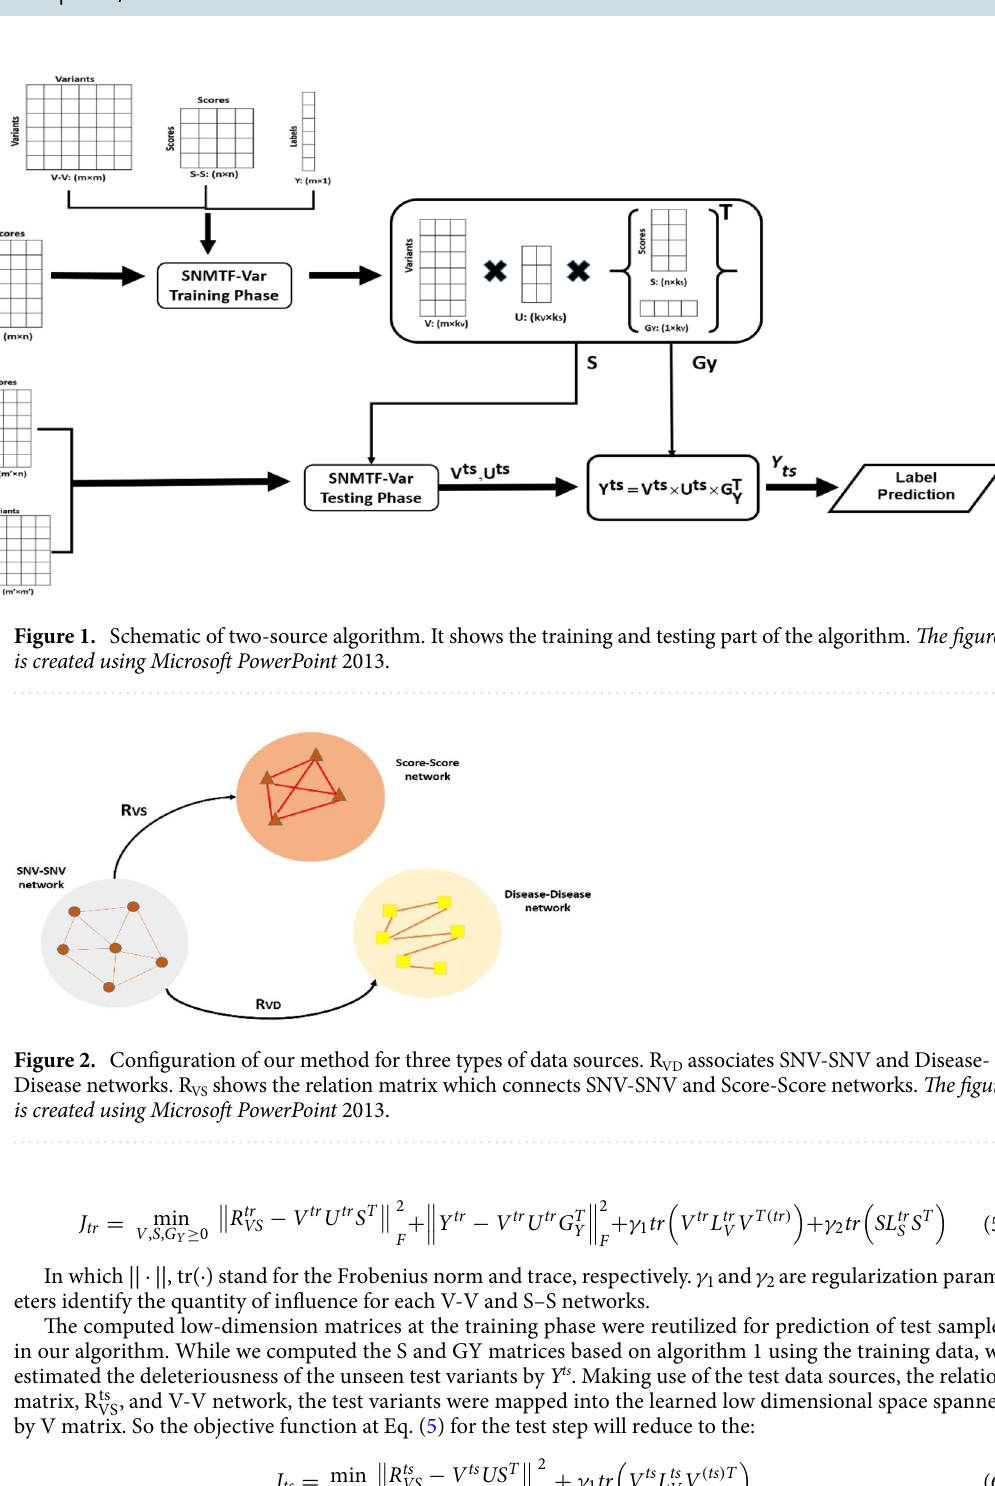
Algorithm 2: supervised matrix factorization with three sources of variants, previous deleteri‑ ous prediction scores and diseases. At the next stage, for our second algorithm we added other database to our two networks, disease information. So we had three intra related matrices, variant-variant, score-score, and disease-disease networks. We connected these three networks via two relation matrices, R VS and R VD . The schematic of networks that include in algorithm 2 is shown at Fig. 2.